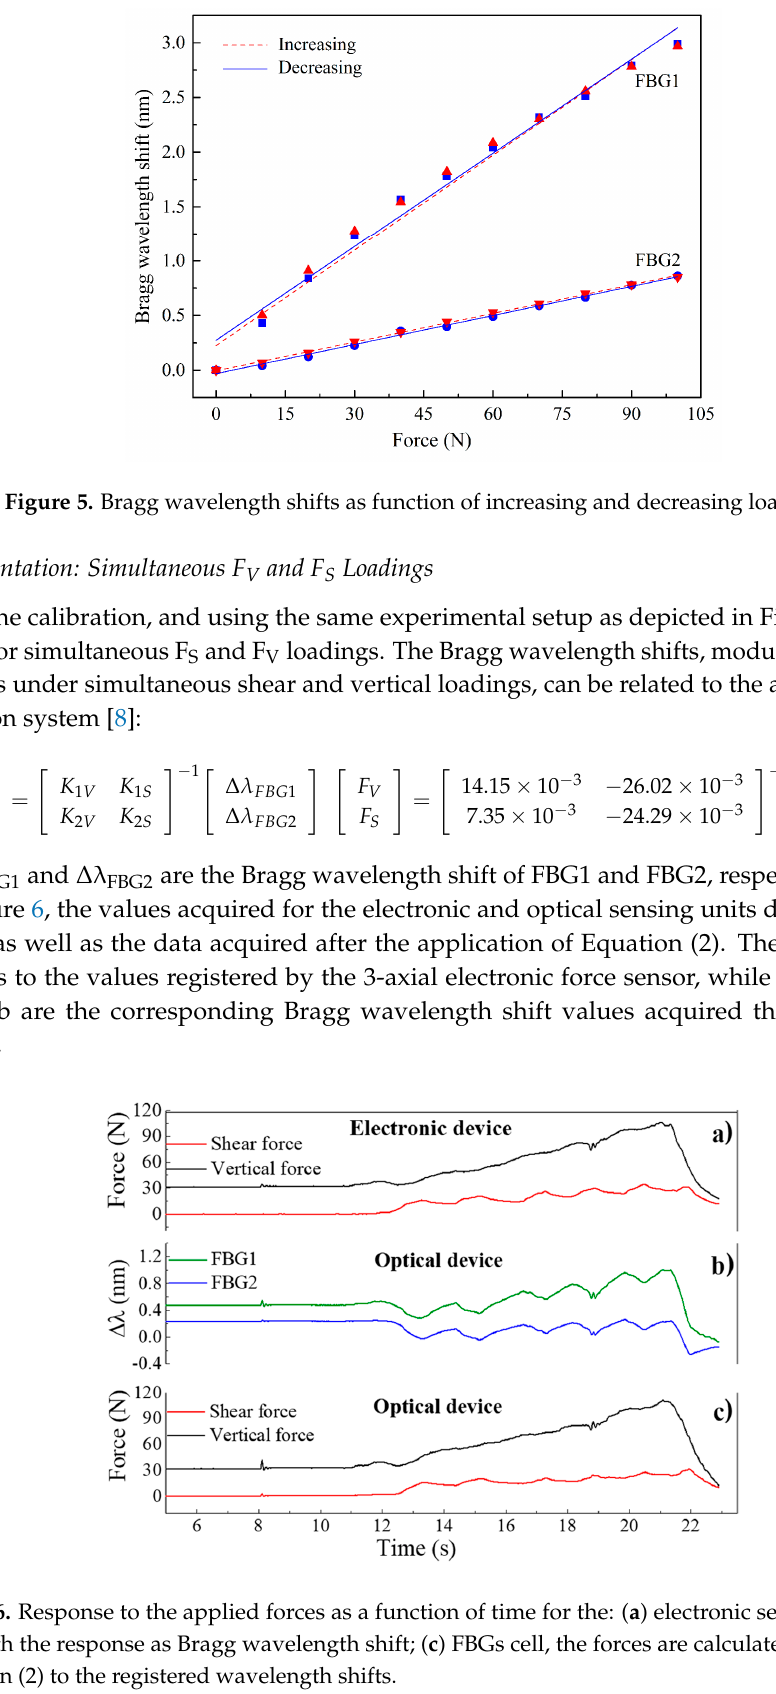
( b ) Figure 4. Calibration data obtained for FBG1 and FBG2 during the variation of the applied forces: ( a ) vertical (with ∆ F S ≈ 0 N) and ( b ) shear (with ∆ F V ≈ 0 N). Symbols are the acquired data and the red line corresponds to the linear fit (R 2 > 0.99). From the calibration representation, a linear dependence of the Bragg wavelength shift with the applied force is verified. The sensitivities obtained for FBG1 and FBG2 as a function of the vertical (K 1V and K 2V ) and shear forces (K 1S and K 2S ) were: K 1V = (14.15 ± 0.10) × 10 − 3 nm/N, K 1S = − 26.02 ± 0.08) × 10 − 3 nm/N, K 2V = (7.35 ± 0.02) × 10 − 3 nm/N, K 2S = ( − 24.29 ± 0.08) × 10 − 3 nm/N. The substantial discrepancy in the vertical force sensitivity values obtained for the two FBGs is